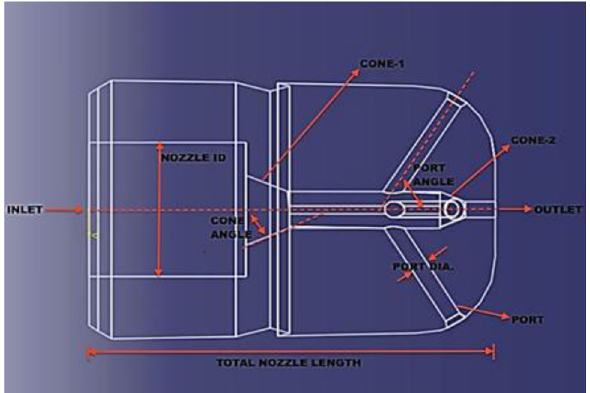
Fig. 5 Components of the nozzle